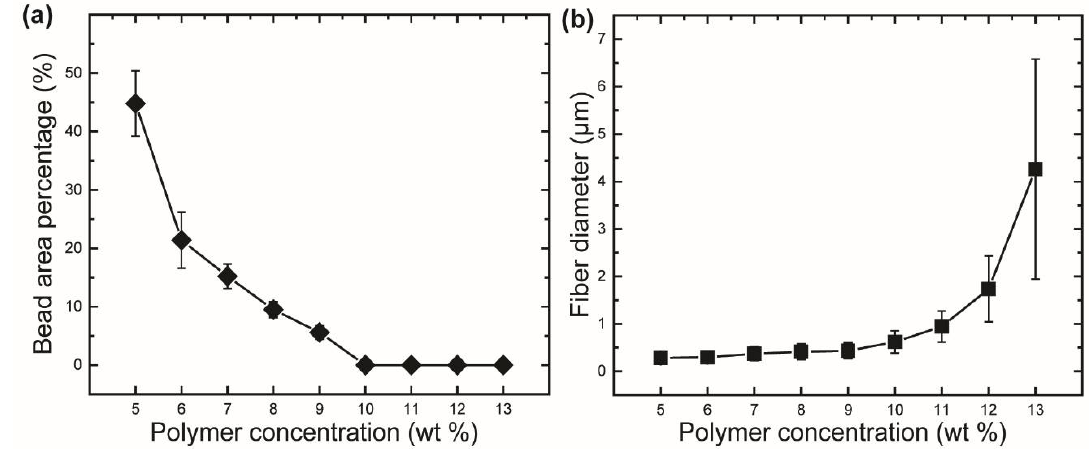
Figure 4. Variation of ( a ) bead area percentage and ( b ) fiber diameter of rPET fibers fabricated from various polymer concentrations. Centrifugal spinning condition: rotational speed, 15,000 rpm; needle inner diameter, 160 μm; collection distance, 10 cm.